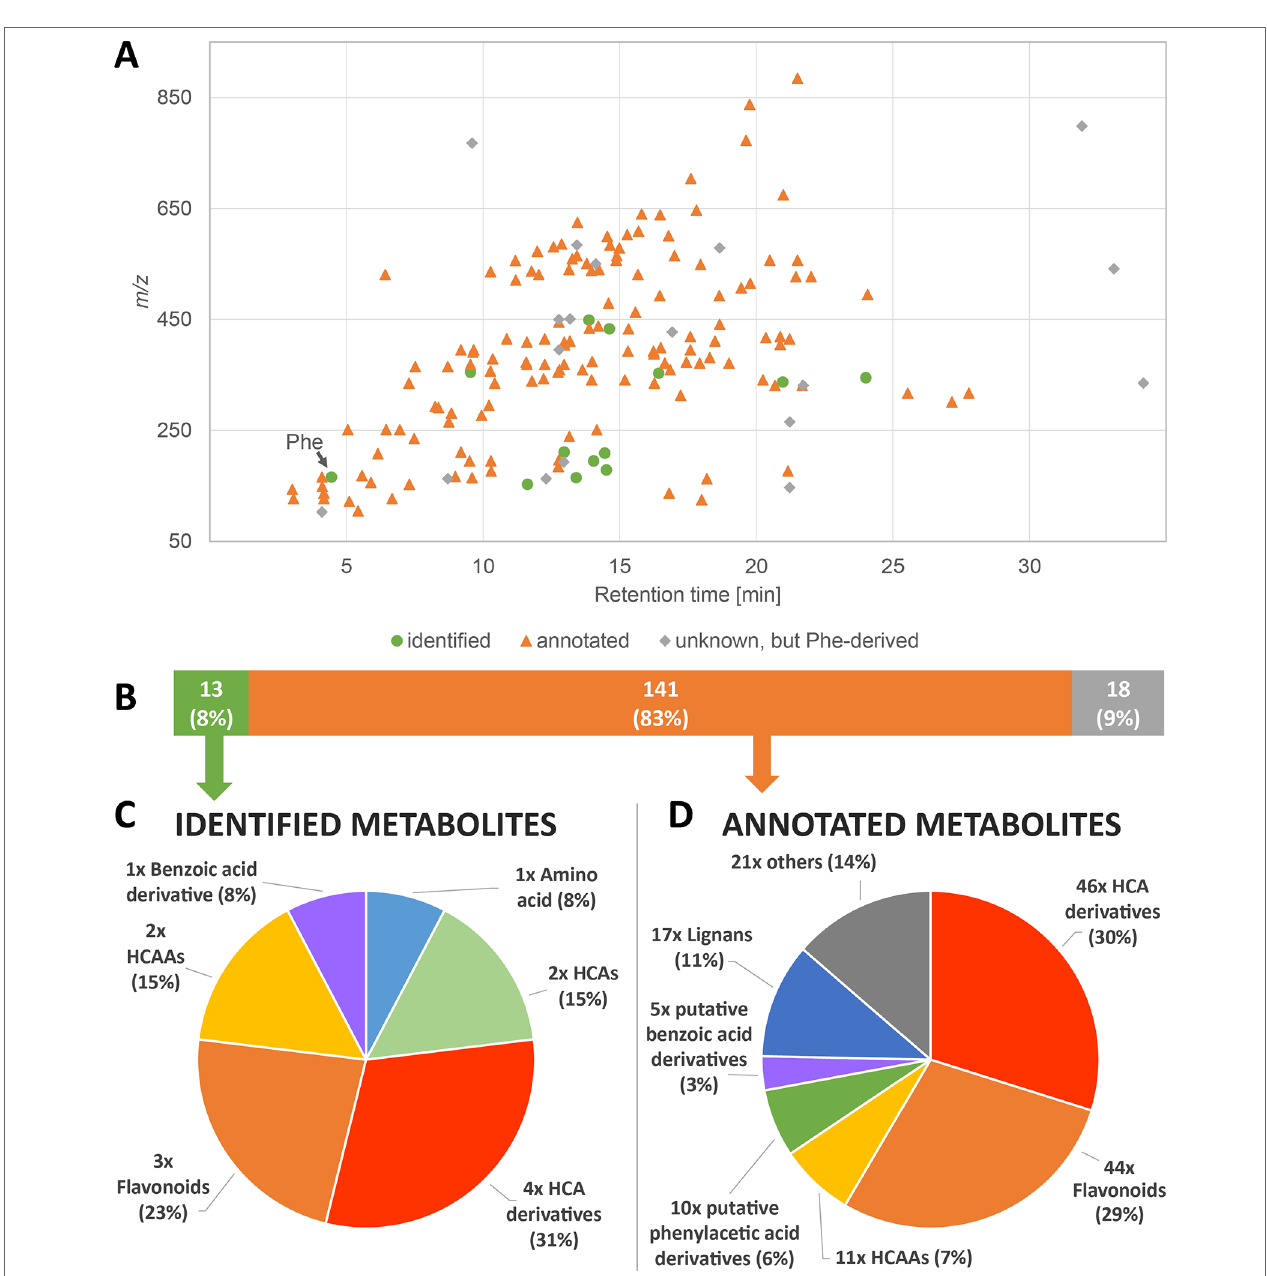
FIGURE 2 | Overview of the detected phenylalanine-submetabolome. (A) Each dot represents one of the 172 phenylalanine-derived wheat metabolites detected in the presented study. (B – D) Overview of identified and annotated compounds and classification of identified (C) and annotated (D) compounds according to their chemical